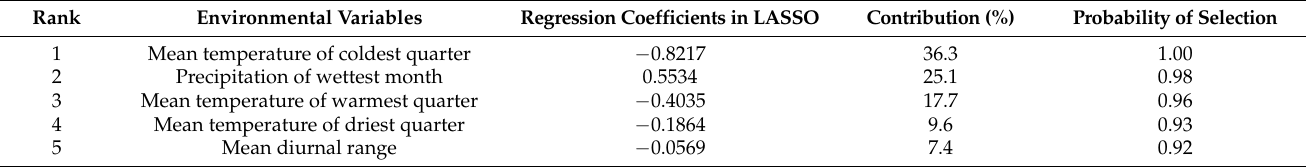
Table 3. Ranking of the importance of variables for prediction of the distribution of T. klimeschi.